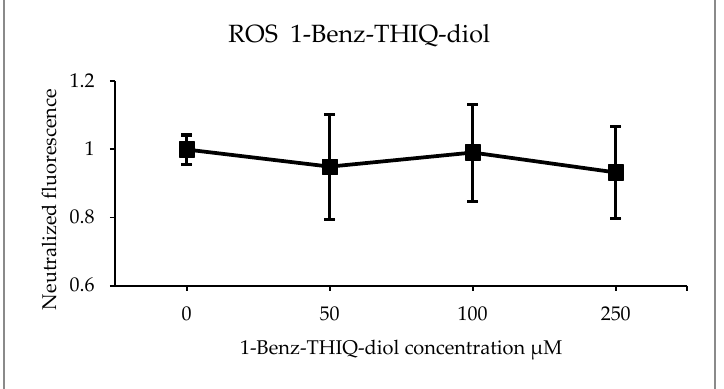
Figure 16. ROS production (percentage of control) after 24 h exposure to different concentrations of 1-Benz-THIQ-diol, data from five biologically independent experiments performed with three technical replicates (mean ± SD) (N = 15). There was no significant difference between the treatments (two-way ANOVA, p = 0.115).